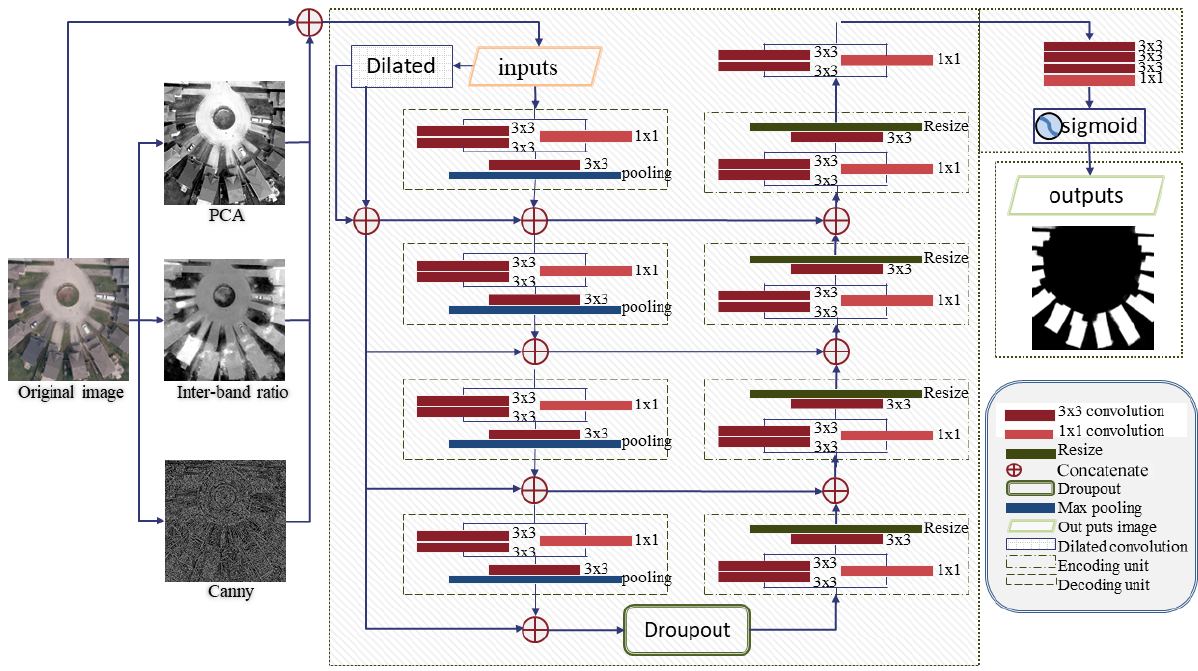
Figure 3. Architecture of eU-Net